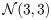
The probability distributions of the background and event pixels at start for two combinations of μ and σ.Fig 18a shows the starting distribution of event pixels distributed as N(3,3) in blue. Fig 6b shows another starting distribution of event pixels, N(1,1) in blue. In both figures the background pixel distribution, N(0,1) is shown in red.